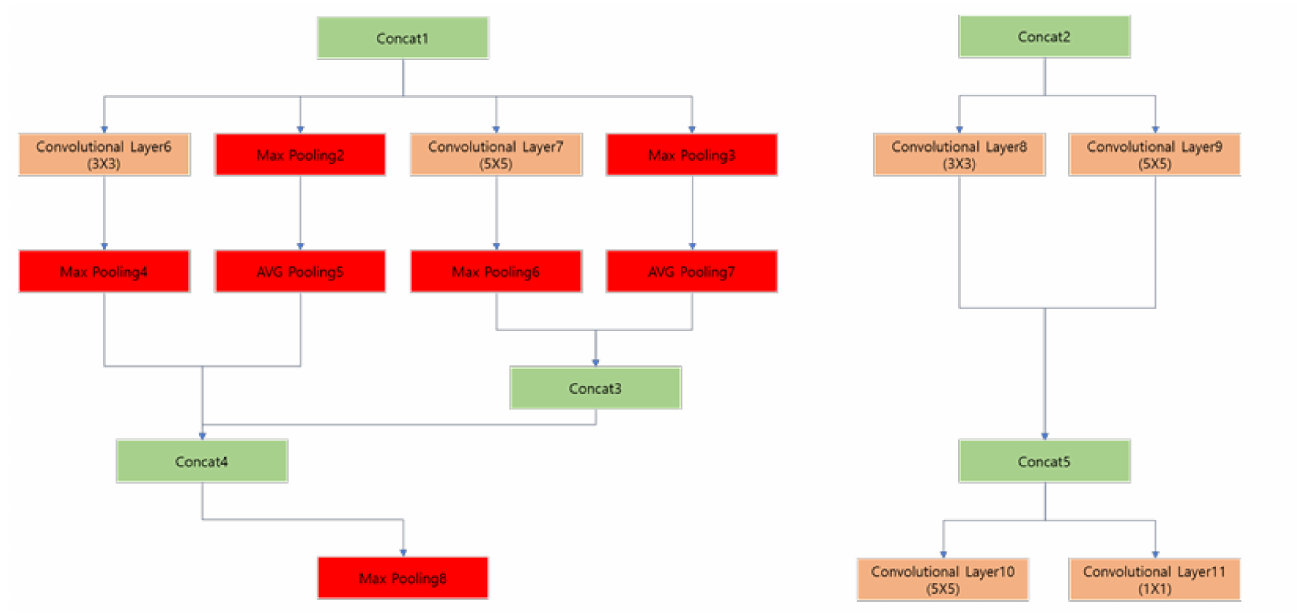
Figure 9. Proposed structure of Convolutional Layer2.